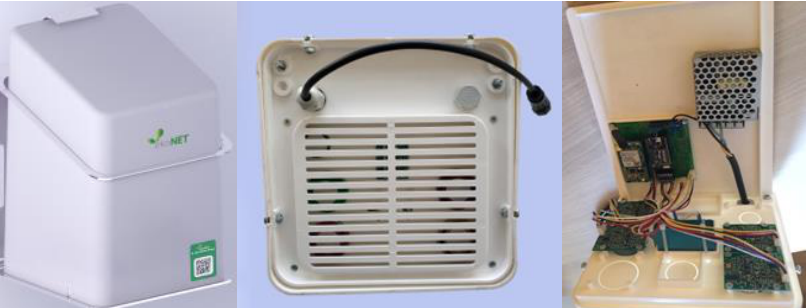
Figure 1. Air quality ekoNET device, AQ10x. The whole device is shown on the left, with the bottom view of the device shown in the middle and the interior shown on the right. The sensors are placed at the bottom of the device, with access to open air, while the power supply and the microprocessor with the data transfer module are placed on the back.